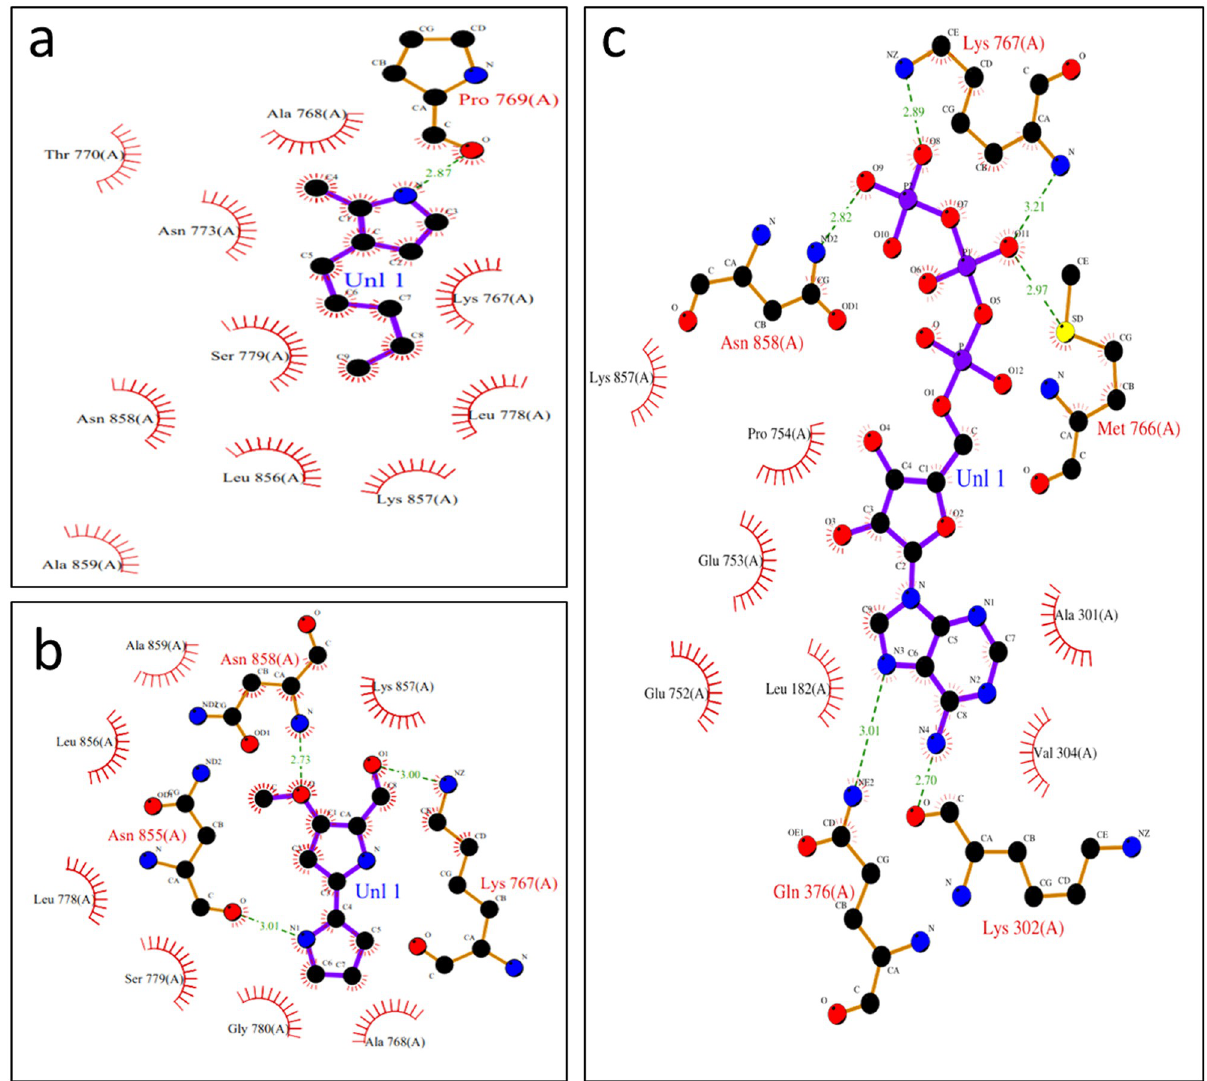
Fig 5. 2D Intermolecular hydrogen bonding interactions of protein and ligand. Protein ligand interactions generated using LigPlot. (a) 2-Methyl- 3-n-amyl-pyrrole (MAP), (b) 4-Methoxy-2,2’-bipyrrole-5-carbaldehyde (MBC), and (c) Adenosine triphosphate (ATP).